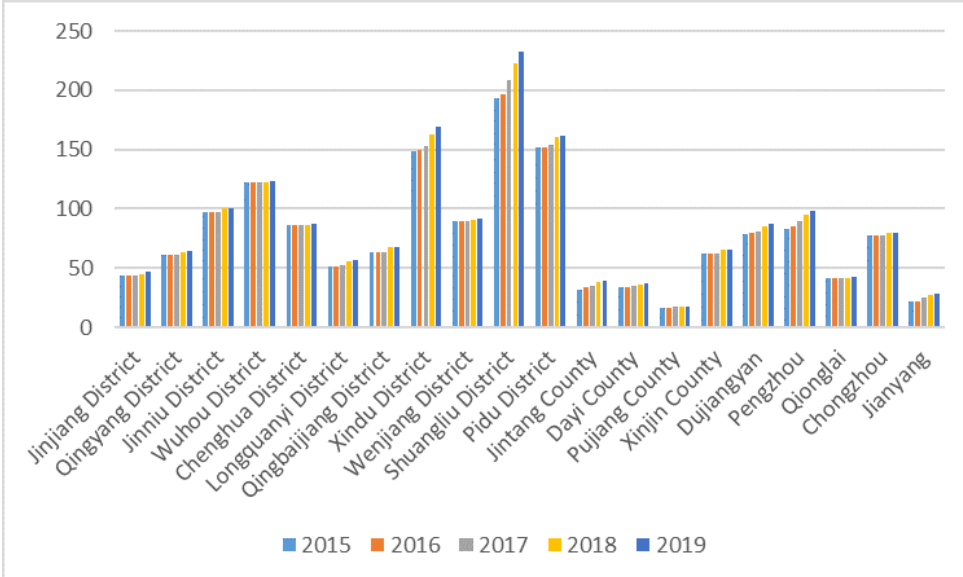
Figure 6. Extracted urban built-up area in different districts in Chengdu.